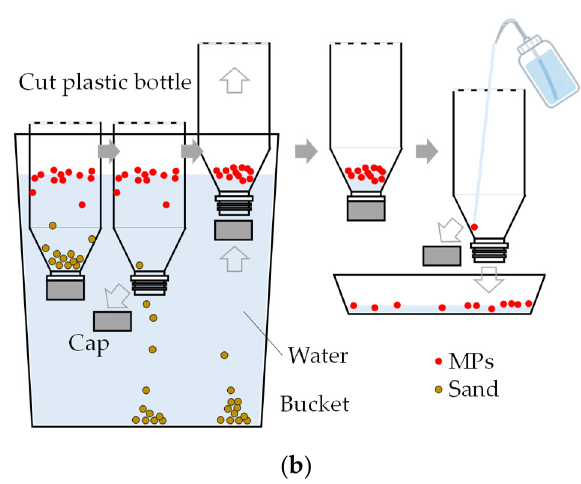
Figure 7. Method of immersing the sorting container in the liquid phase: ( a ) water leakage prevention by inserting a partition plate into the sorting container in the liquid phase; ( b ) MP sorting using the bottle method.